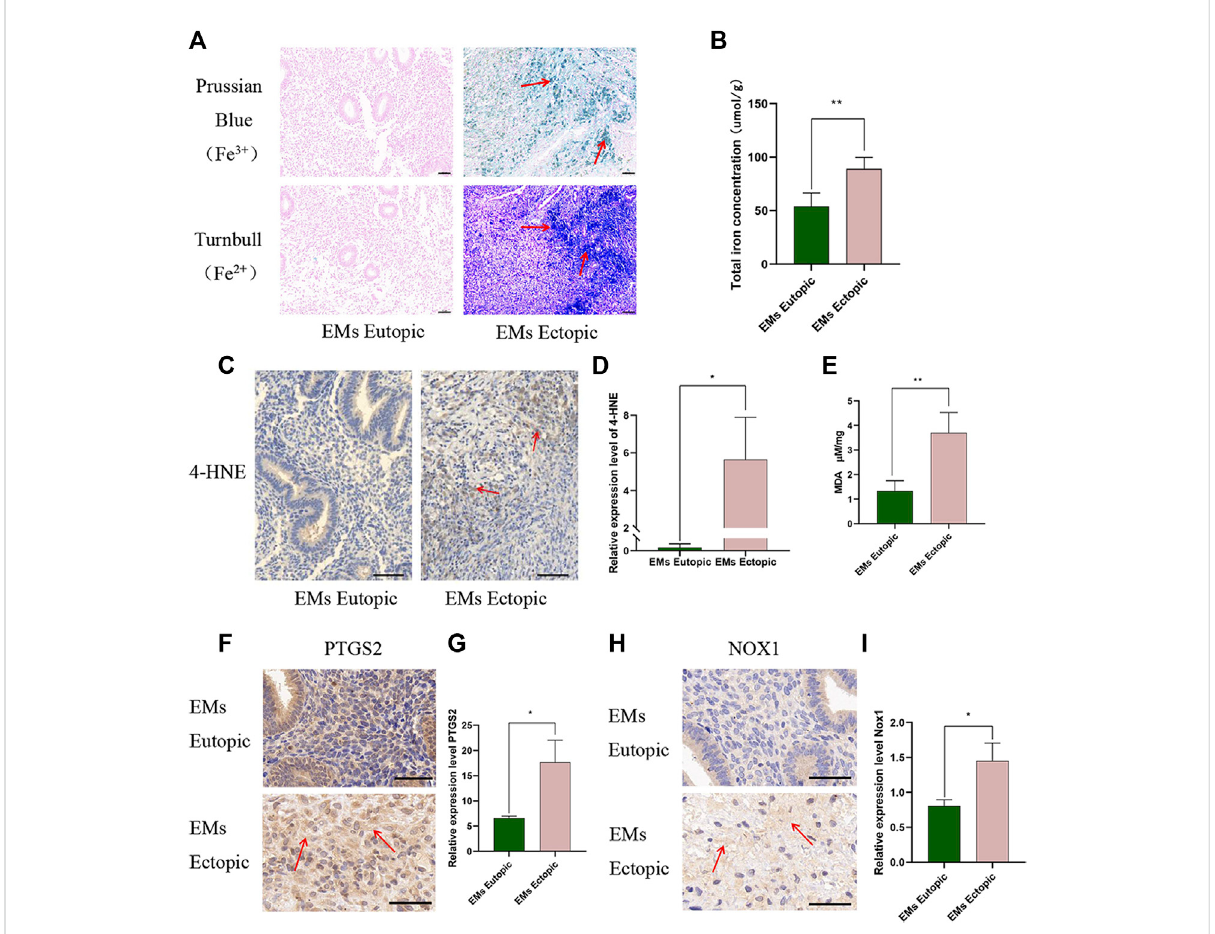
Iron level and ferroptosis products increased in ectopic tissues compared with eutopic tissues. (A) Ferric iron (Fe 3+ ) and ferrous iron (Fe 2+ ) were detected in ectopic tissues compared with eutopic tissues. Ferric iron (Fe 3+ ) was detected by Prussian blue, high expression is depicted in green and the ferrous iron (Fe 2+ ) was measured by Turnbull high expression is depicted in blue. (B) Total iron level (iron ion and ferritin-bound iron) in EMs eutopicandectopictissuesmeasuredbyIronAssayKit(NanjingJiancheng,A039-2). (C – D) Representativeimages (C) andquantitativeanalyses (D) of ectopic and eutopic tissues stained with anti-4-HNE. (E) MDA levels in EMs eutopic and ectopic tissues were measured by MDA Assay Kit (ab118970). (F – G) Representative images (F) and quantitative analyses (G) of ectopic and eutopic tissues stained with anti-PTGS2. (H –